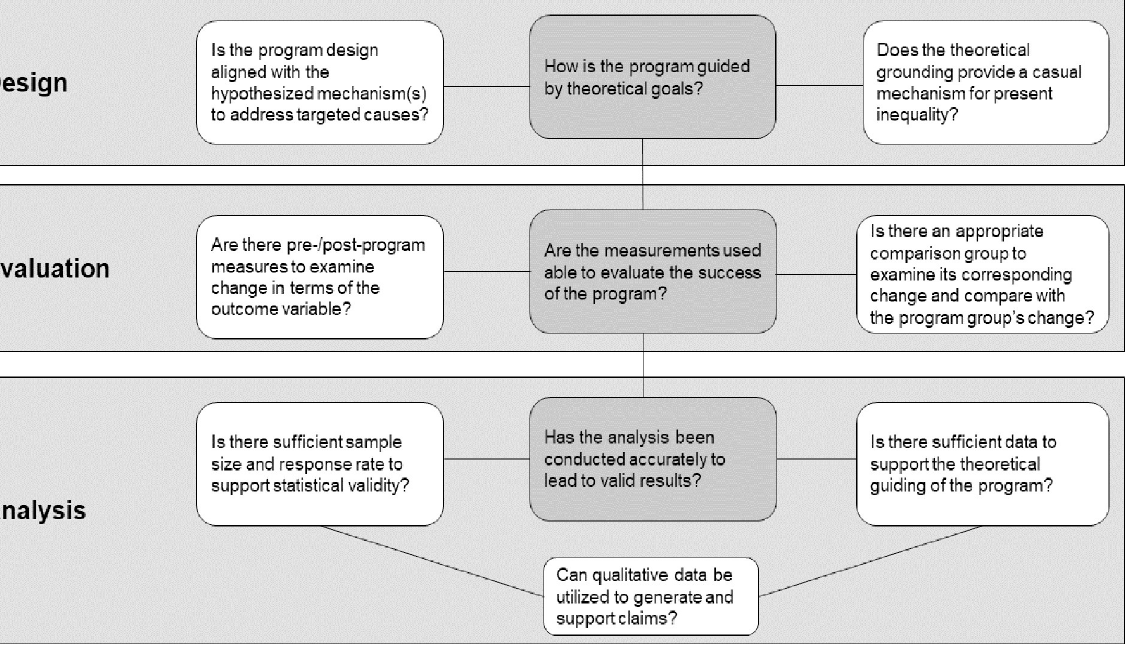
Fig 14. Illustrates the connection among design, evaluation, and analysis